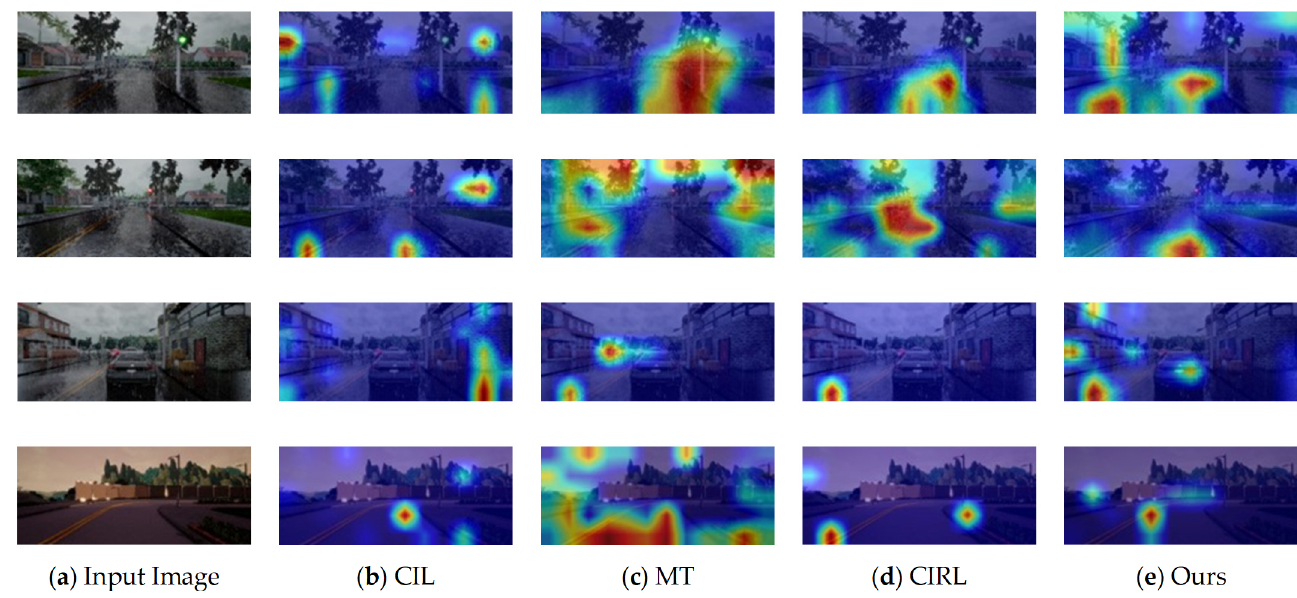
Figure 7. Qualitative Results Analysis by Grad-CAM Visualization.